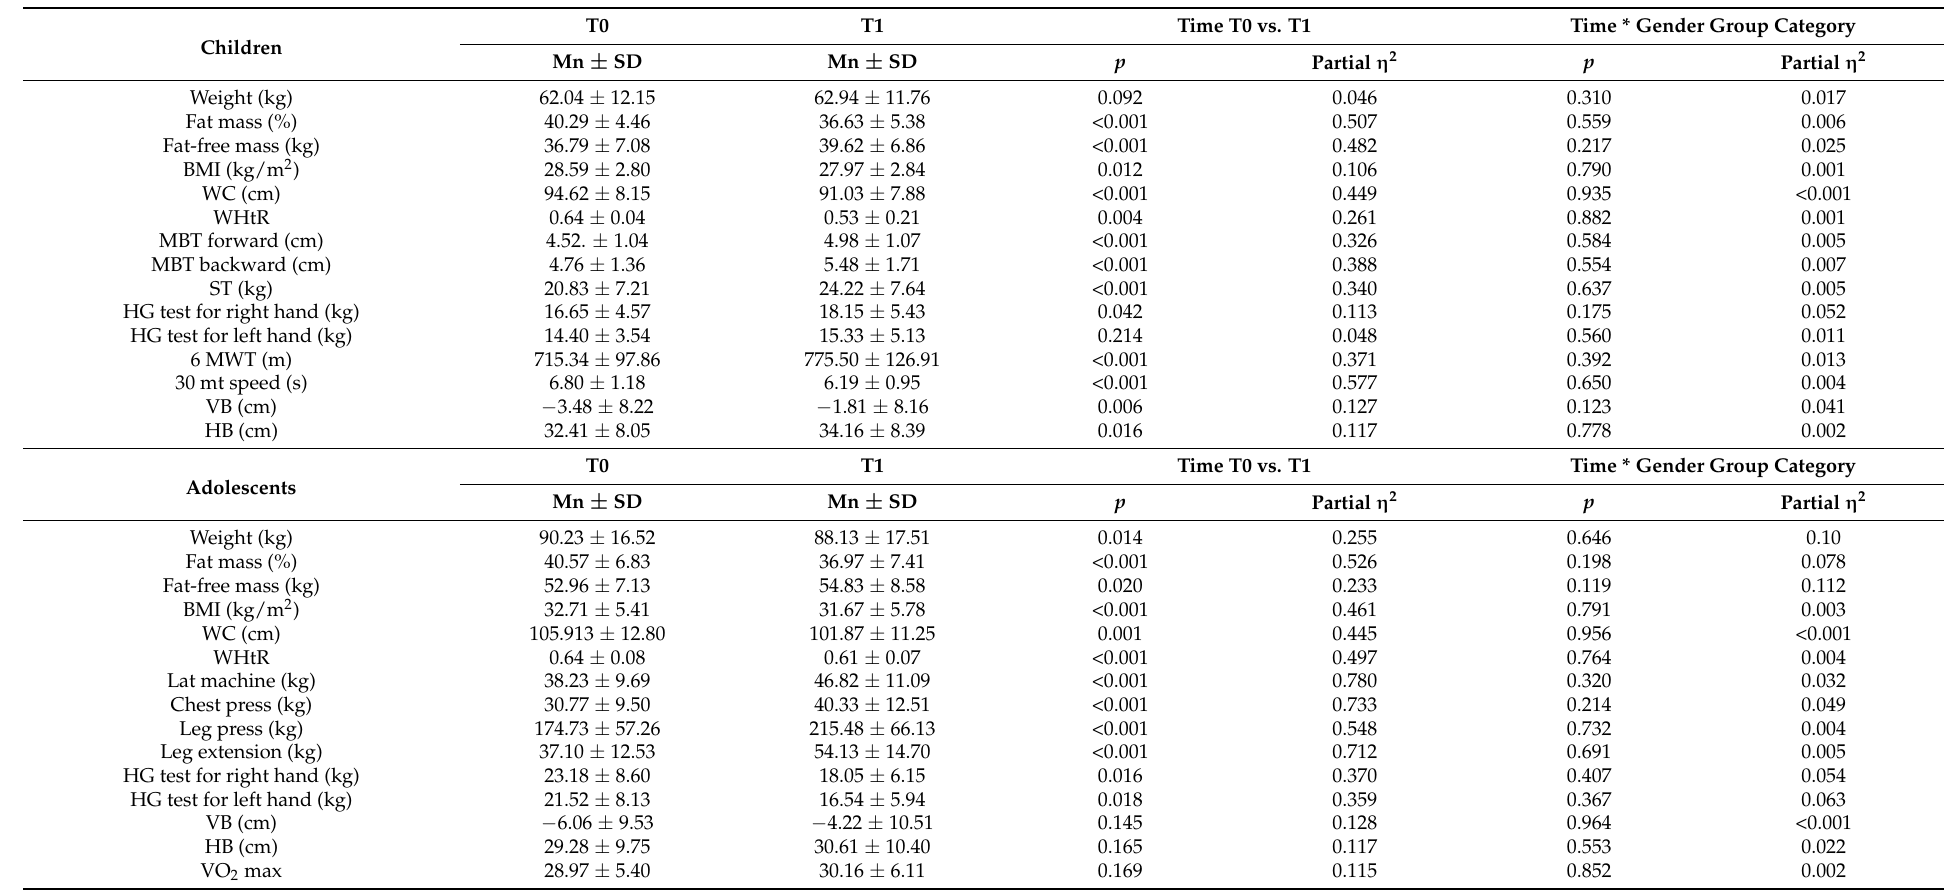
Legend: BMI = body mass index; WC = waist circumference; WHtR = waist-to-height-ratio; LAT = lat machine test value; CHEST = chest press test value; PRESS = leg press test value; LEGEXT = leg extension test value; HG = Hand Grip test value; VB = vertical bending test value; HB = horizontal bending test value; VO 2 max = maximal oxygen consumption